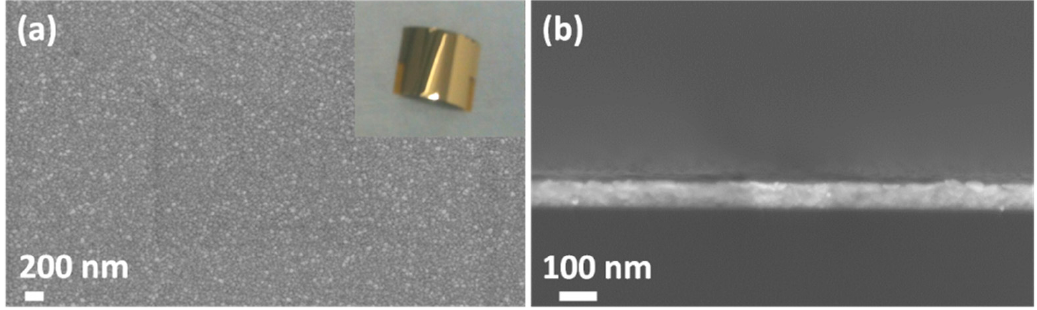
Figure 1. FESEM images of Au layers deposited on ( a ) Polyimide and ( b ) Si wafer. Inset of panel ( a ) shows a picture of the Au-coated Polyimide specimen.